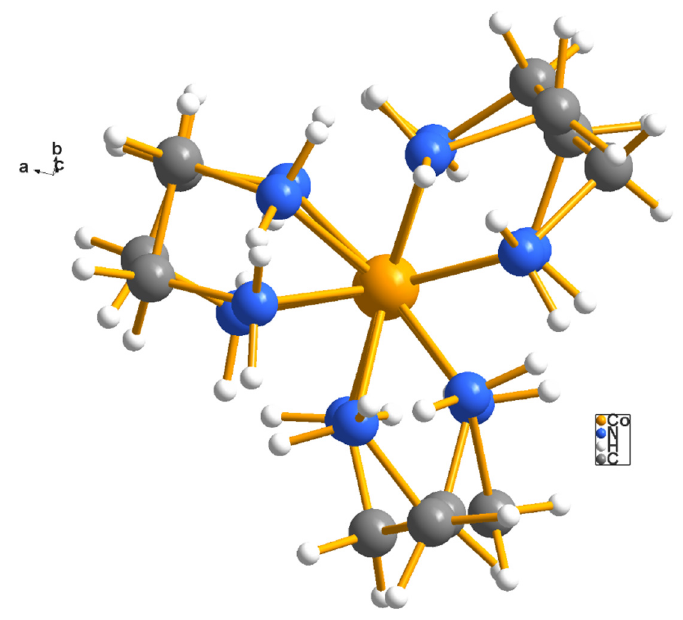
Figure 3. Overlay of inverted Co2 onto Co1, optimizing the fit. Drawing generated using Mercury [5] and Diamond [6].